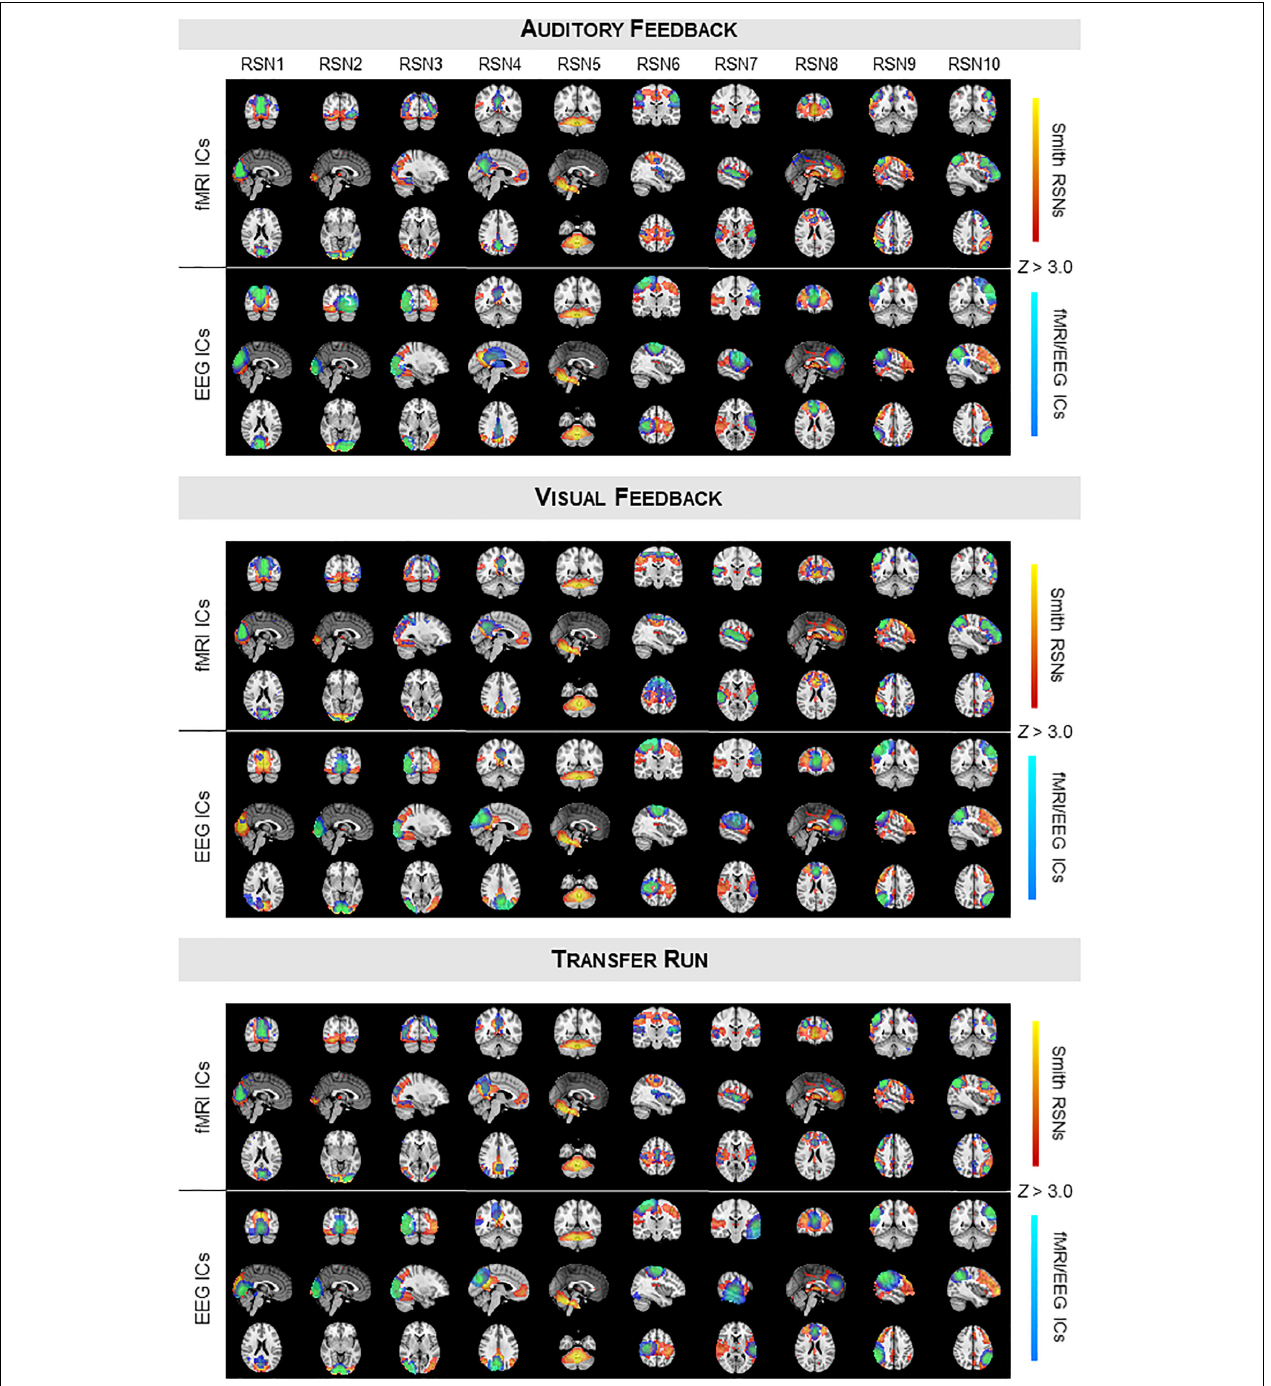
FIGURE 1 | Group RSNs identified on fMRI and EEG-ESI data for the auditory feedback (top) , visual feedback (middle) , and transfer runs (bottom) . For each run, the RSN templates (in red–yellow) from Smith et al. (2009) are superimposed with the fMRI (top) and EEG (middle) ICs (in blue–light blue) selected for each RSN template, according to their Dice